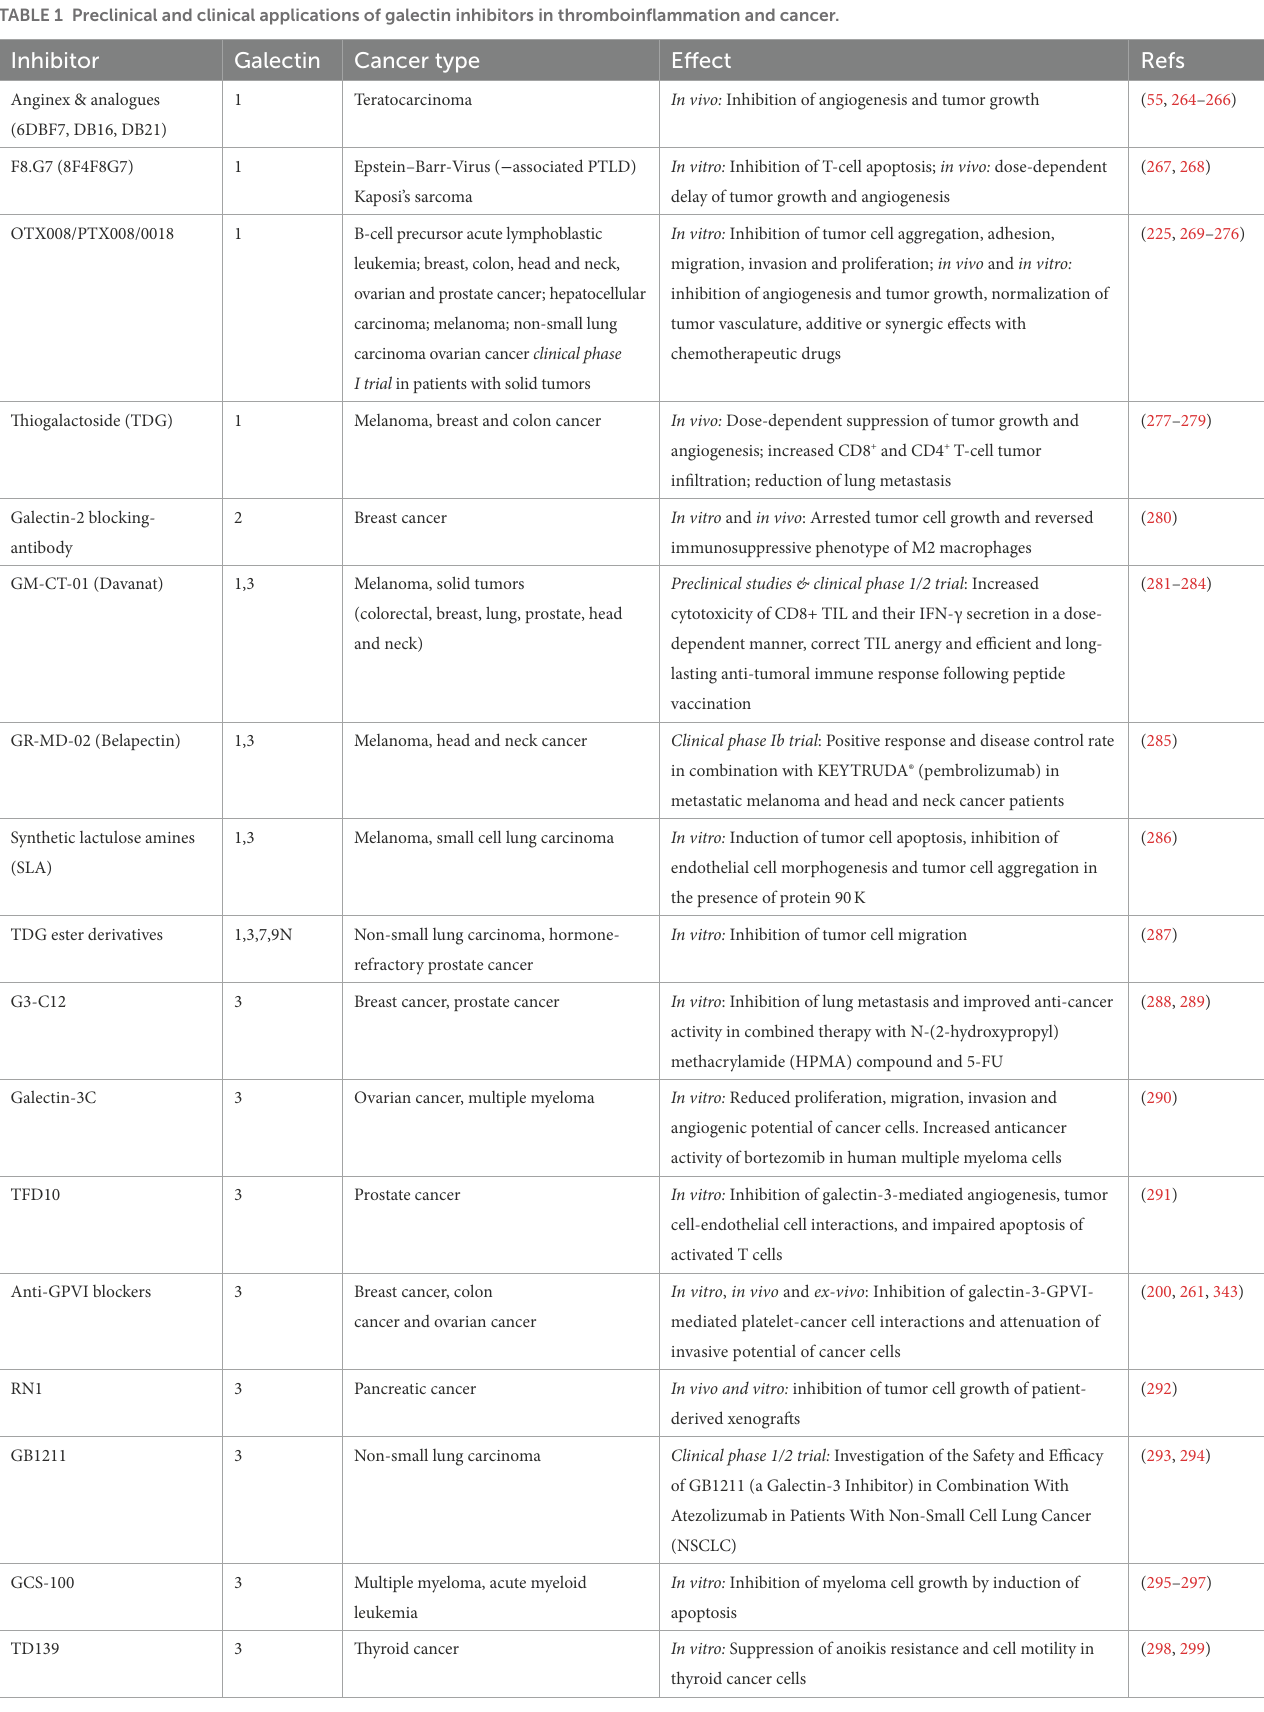
TABLE 1 Preclinical and clinical applications of galectin inhibitors in thromboinflammation and cancer. Inhibitor Galectin Cancer type